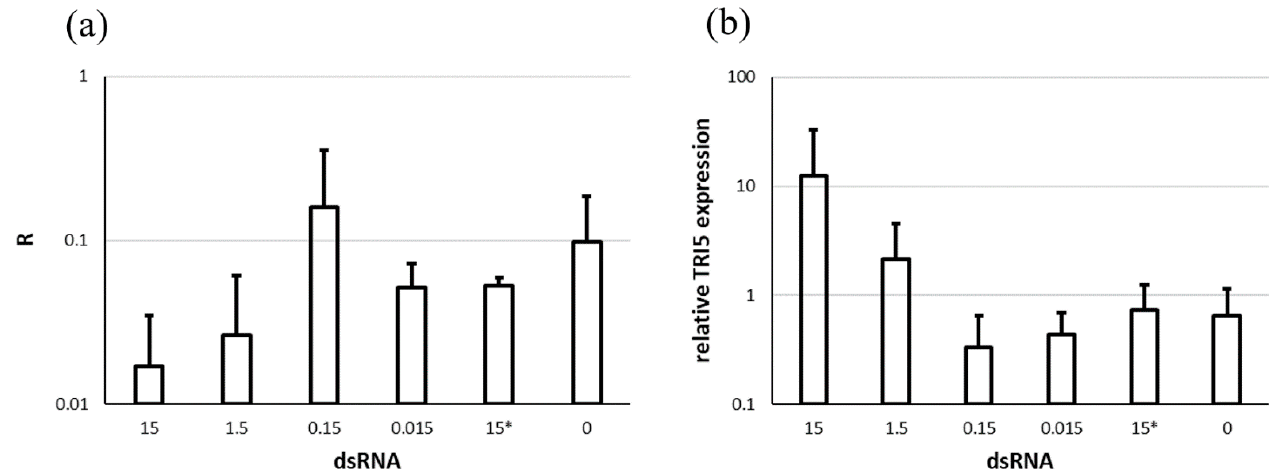
Figure 8. F. culmorum quantification and relative TRI5 expression on wheat heads after spraying with various amounts of dsTRI5RNA. ( a ) Quantification of F. culmorum in the wheat heads based on EF1A relative to wheat Act . R calculated with formula (2). ( b ) Expression of the TRI5 gene in F. culmorum growing in the wheat heads. Expression is relative to the control sample, using EF1A as a reference gene. Numbers on x-axes are amounts in µg of dsRNA, * indicates non-target dsRNA. The graph shows the means and standard deviations of at least two biological replicates or 2 heads.